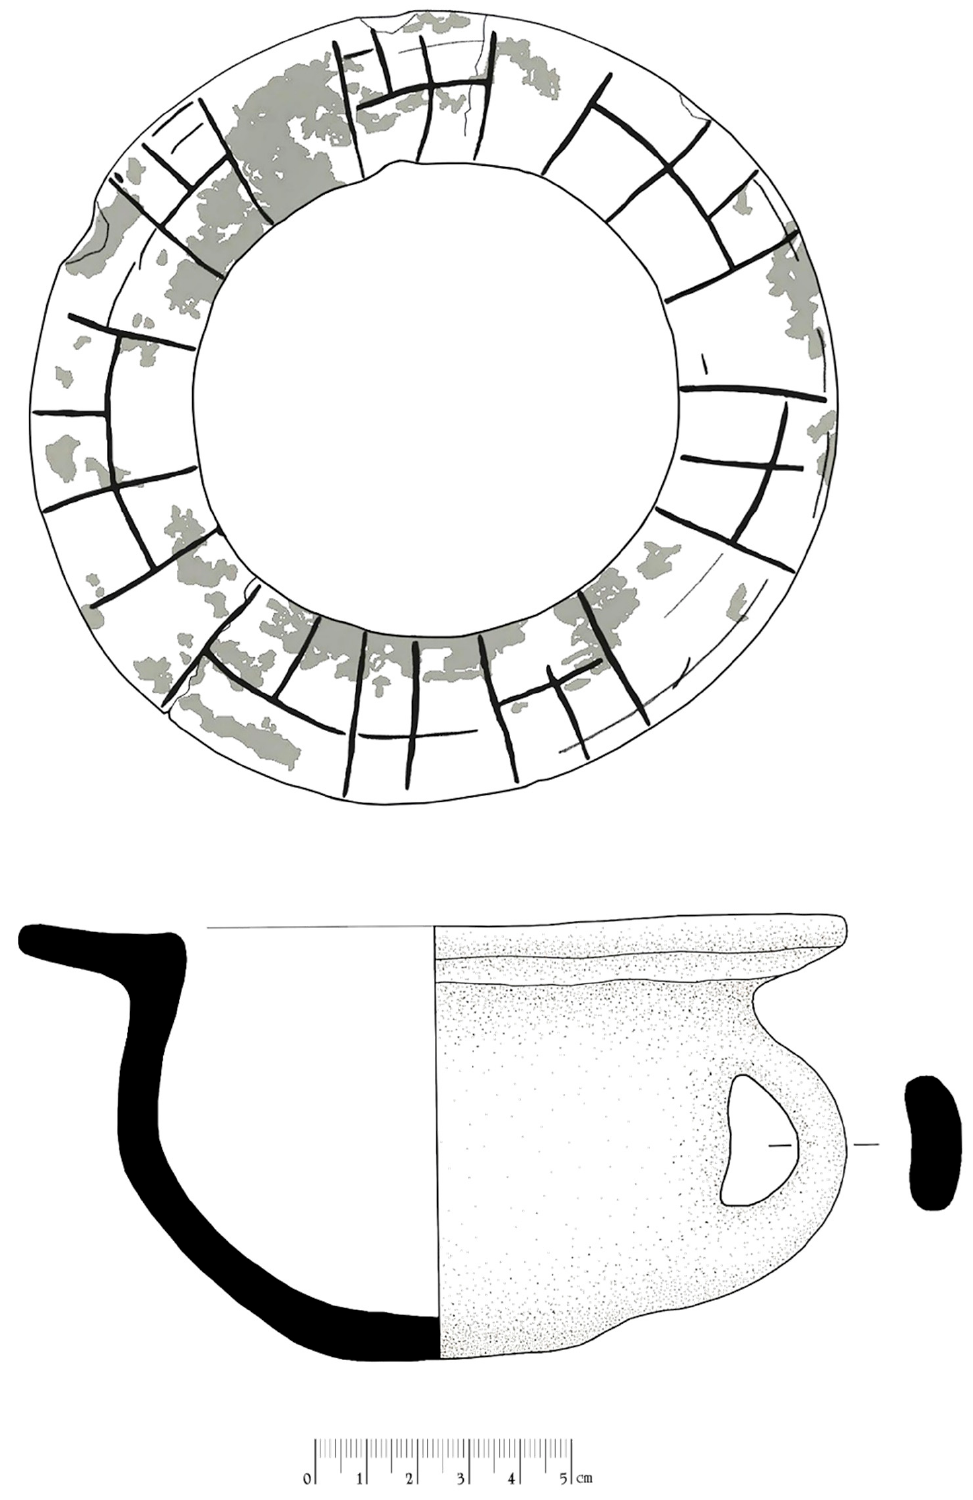
Figure 4. Decorated rim and shape of the WHR vessel.